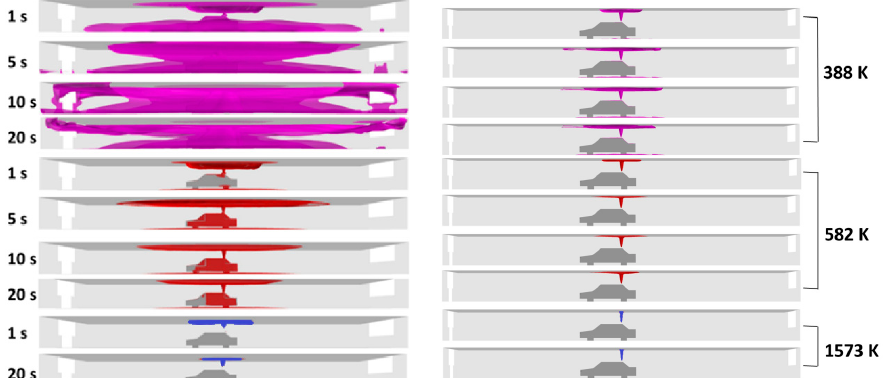
Figure 7. Side view iso-surfaces showing pain limit (388 K), fatality limit (582 K), and flame visible (1573 K) temperatures. ( Left ): case 3 (TPRD = 2 mm, upward release with tank blowdown from distance 1.13 m to the ceiling). ( Right ): case 8 (TPRD = 0.5 mm, upward release with tank blowdown from distance 1.13 m to the ceiling).